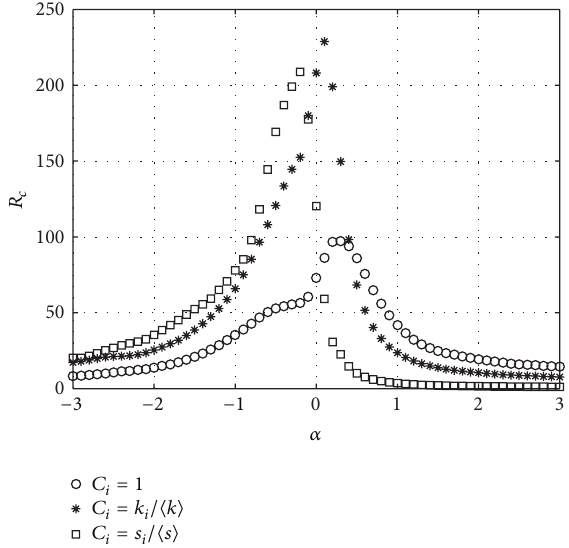
Figure 1: 𝑅 𝑐 versus 𝛼 . BBV network with 𝑛 = 1000 , 𝛿 = 6 , 𝑚 = 6 , and 𝜔 0 = 1